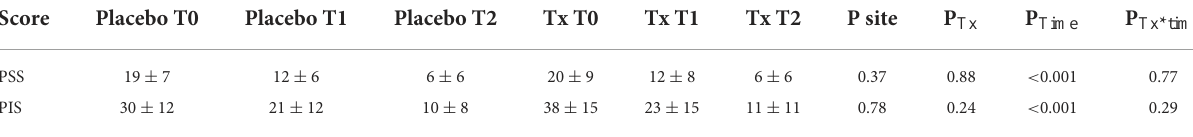
TABLE 3 Results of pain severity score (PSS) and pain interference scores (PIS) in dogs treated with either a cannabidiol (CBD) and cannabidiolic (CBDA) rich hemp product (2–2.5 mg/kg orally every 12h; n = 22) or a placebo (sesame seed oil every 12h, n = 19) for 4 weeks after a tibial plateau leveling osteotomy